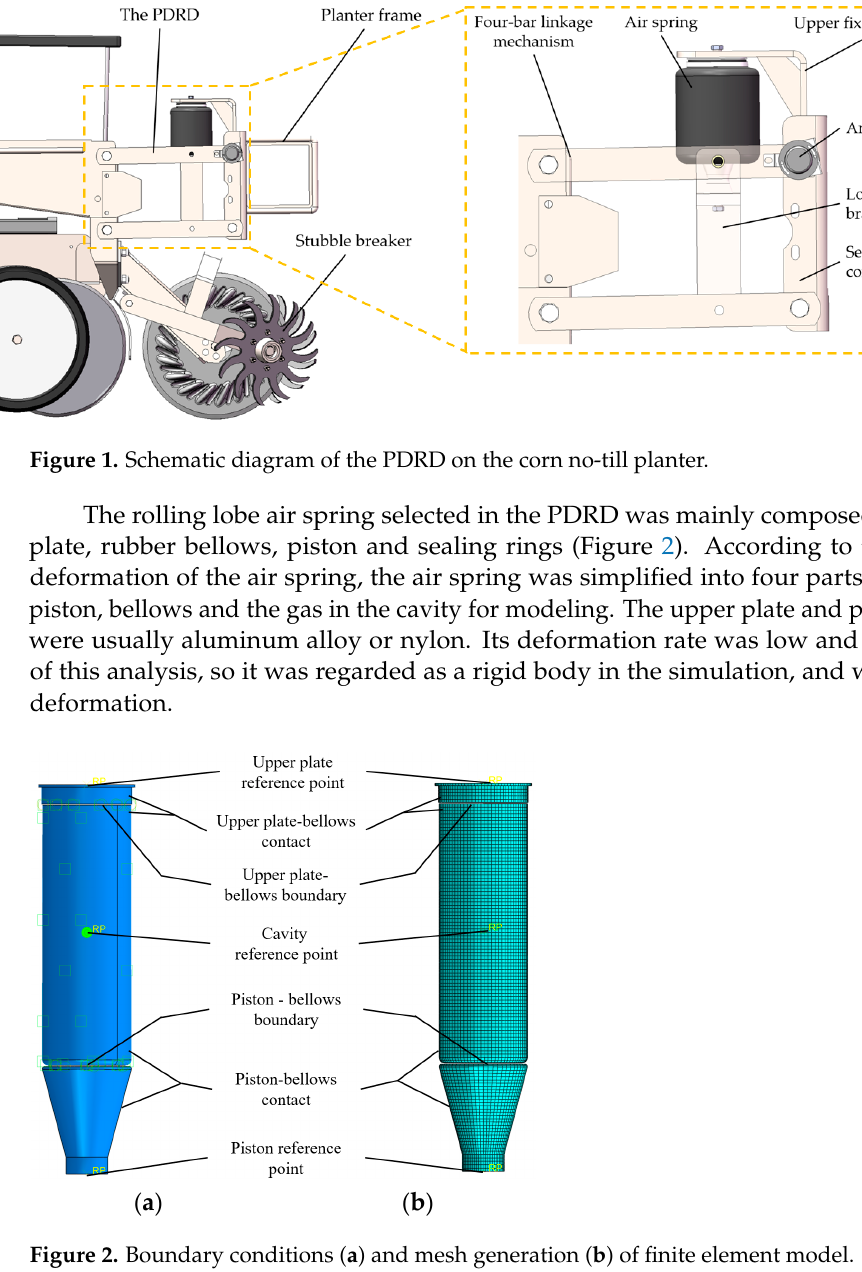
Table 1. Physical parameters of bellows materials.